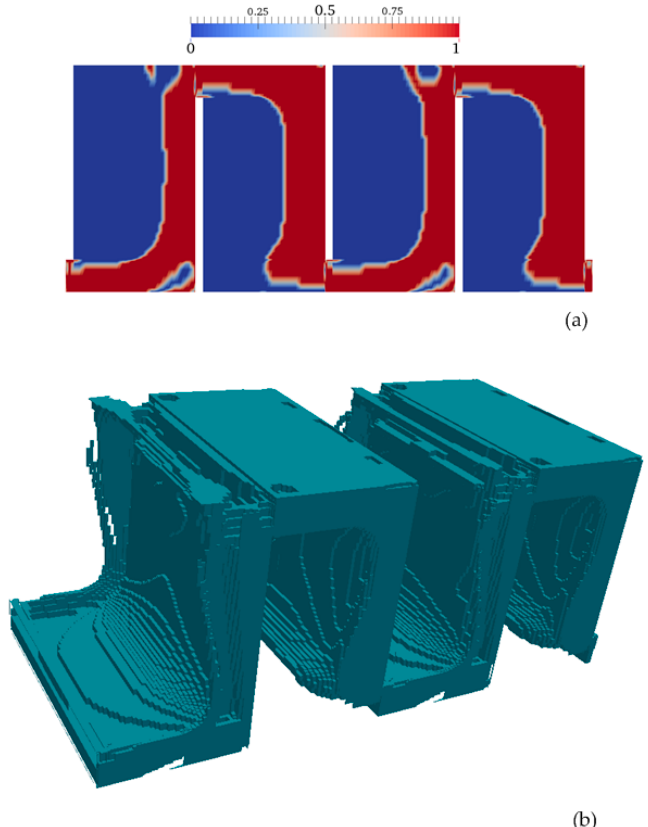
Figure 11. Visualization of the jet region using the flexion product for RANS: ( a ) on the x – y plane at mid span ( z = L /2); ( b ) a three-dimensional view of the jet regions in each